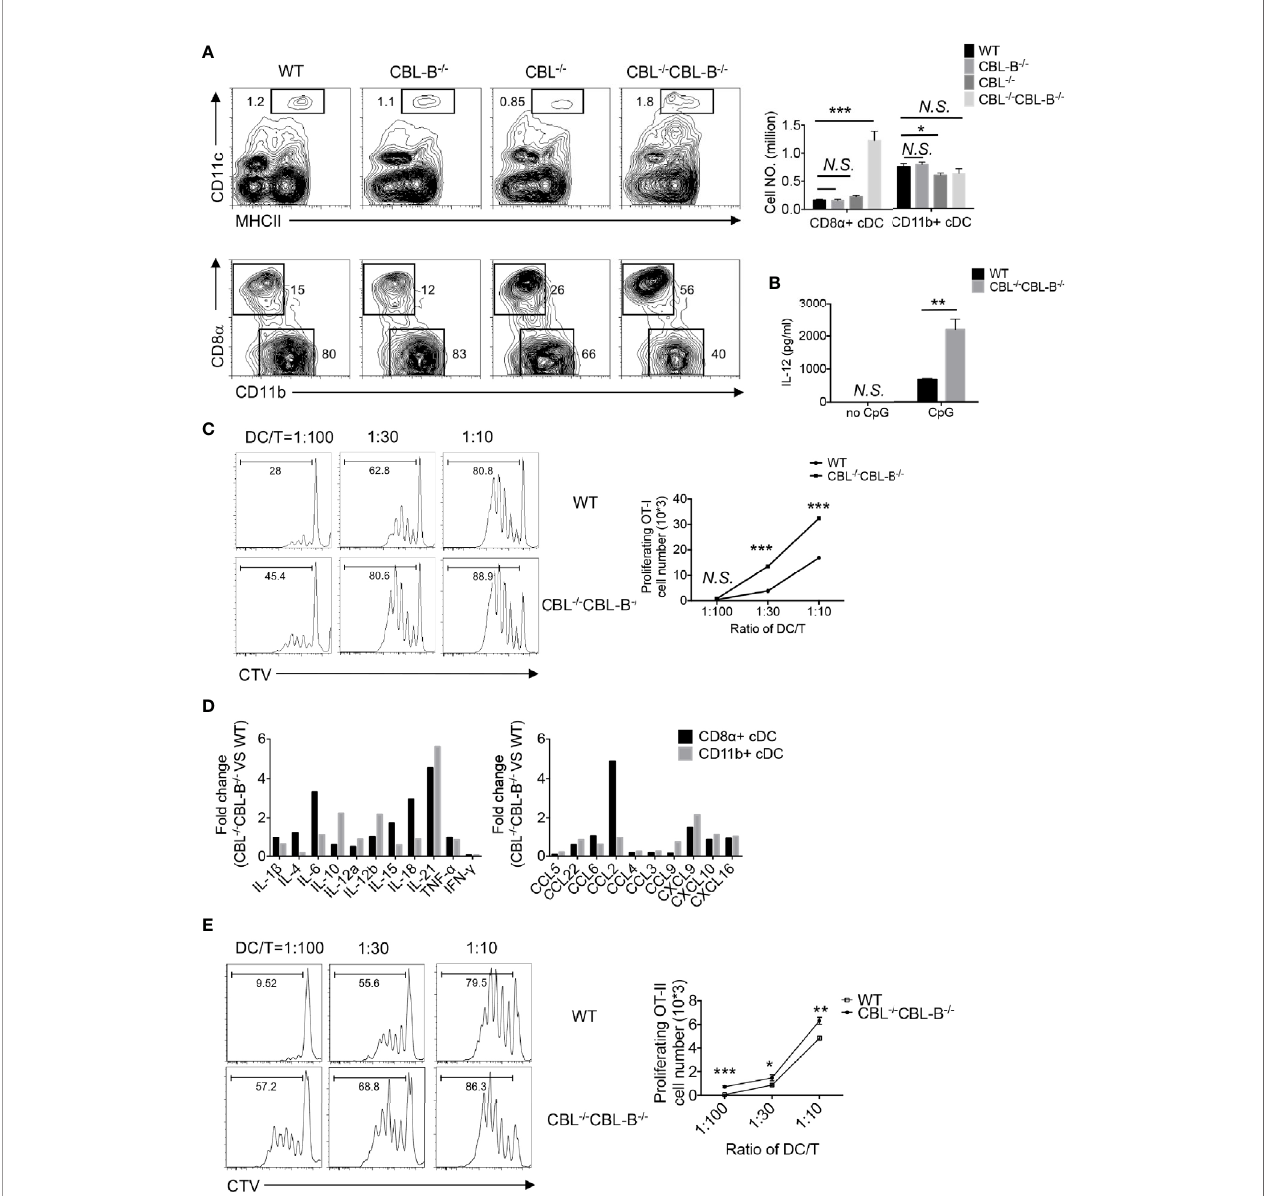
FIGURE 1 | Analyses of the DC development in WT and CBL -/- CBLB -/- mice. (A) Flow cytometry and statistical analyses of splenic cDCs. CD11c vs MHC-II staining of total splenic cDCs (Top panel), CD8 a vs CD11b staining of CD8 a + cDC1 and CD11b + cDC2 (bottom panel), and statistics (right bars) (n = 5). (B) IL-12 production by WT and CBL -/- CBL-B -/- cDC1 upon CpG stimulation (n = 3). (C) Antigen cross presentation to CD8 + T cells by WT and CBL -/- CBL-B -/- CD8 a + cDC1. Histograms of OT-I CD8 + T cell proliferation (left). Statistics of OT-I CD8 + T cell proliferation (right) (n = 3). (D) RNAseq analyses of cytokine and chemokine pro fi les of CD8 a + cDC1s and CD11b + cDC2s. (E) Comparison of the antigen presentation ef fi ciency of WT and CBL -/- CBL-B -/- cDC1s to CD4 + T cells (n=3). Data are mean ± SEM. of at least two independent experiments (A – E) . N.S., not signi fi cant; *p < 0.05; **p < 0.01; ***p <